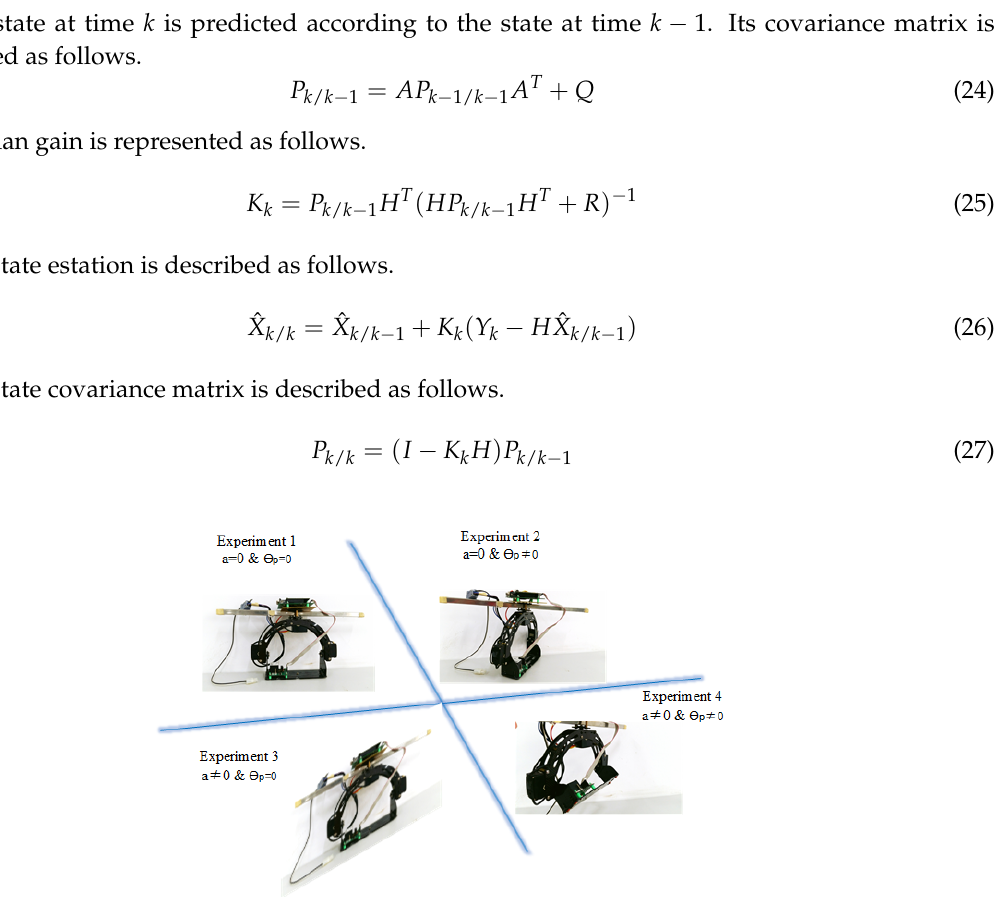
Figure 7. Experimental